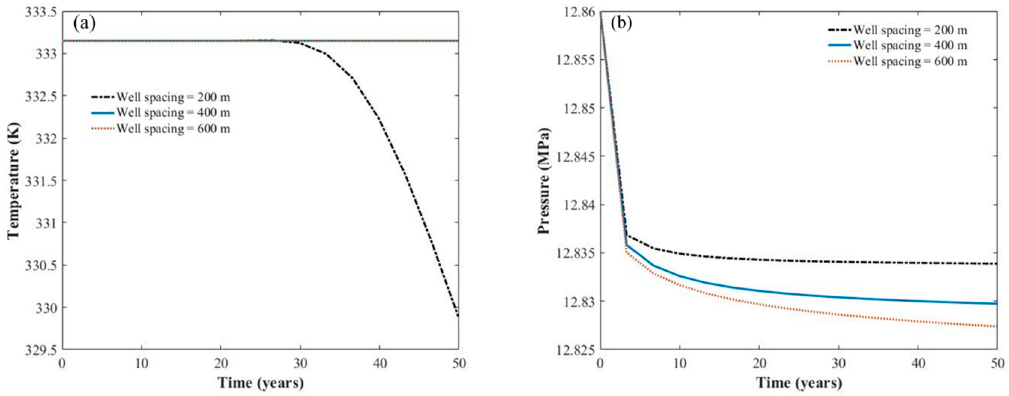
Figure 6. Time evolution of production well in well spacing studies: ( a ) temperature at production well; ( b ) pressure at production well.